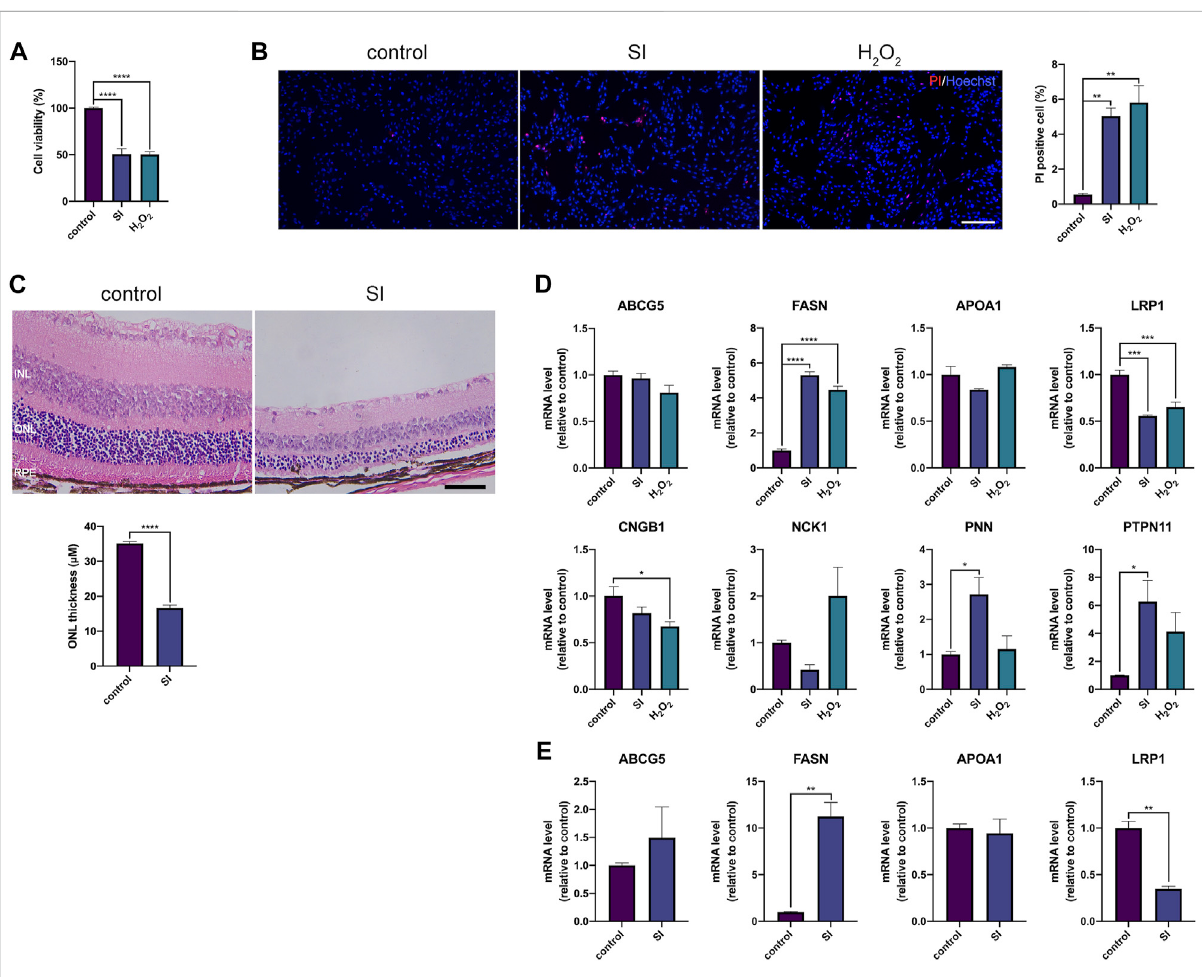
FIGURE 6 (A) CCk-8results ofRPEcellsthatwereunderSI(40 mM)orH 2 O 2 (200 μ M)treatmentfor4 h (B) Representative imagesandthecorresponding statistical result of PI staining. The cells were under SI (40 mM) or H 2 O 2 (200 μ M) treatment for 4 h; scale bar = 200 μ m (C) H&E staining of